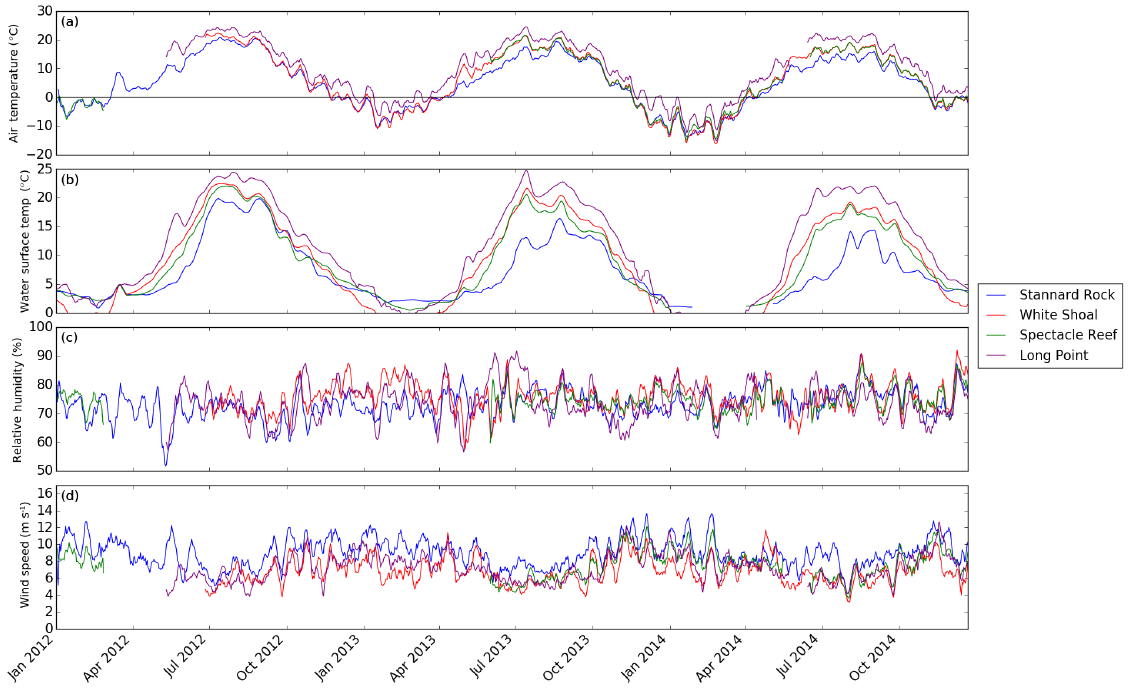
Figure 3. Running mean time series (10 days) of meteorological variables at the four stations. Air temperature and relative humidity were measured with Vaisala HMP45C thermo-hygrometers, and wind speed was measured with the CSAT-3 (see Sect. 2.1.1 or Fig. 1 for the sensor heights). Water surface temperature is taken from GLSEA. Data at pixels closest to the stations are used. The data gaps in water surface temperature from January to April denote periods during which the site was affected by lake ice cover. Measurements at Long Point and White Shoal started in May and June of 2012. There is also a long data gap between February 2012 and June 2013 at Spectacle